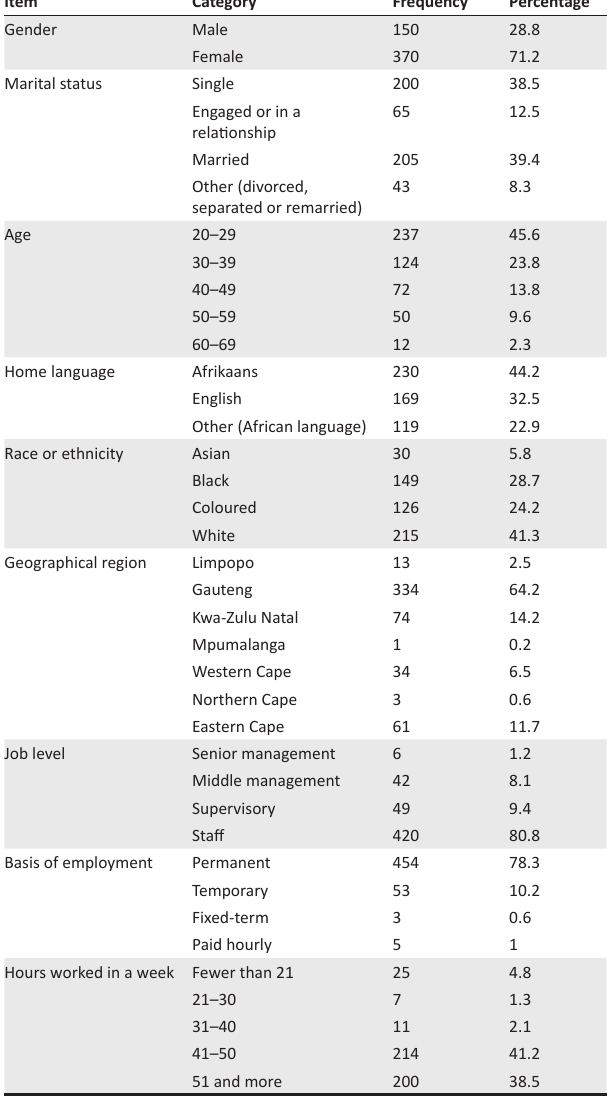
TABLE 1: Demographic characteristics of the